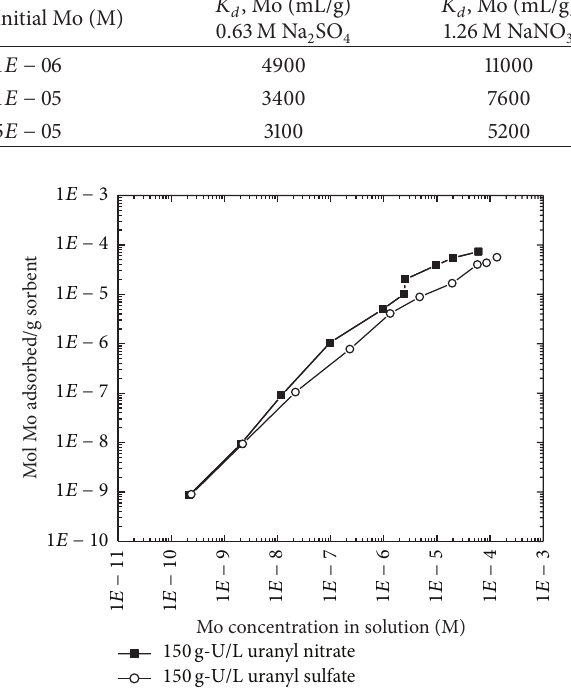
Figure 1: Amount of Mo adsorbed per gram of sorbent versus the amountinsolutioninthepresenceofsolutionscontaining150 g-U/L uranyl nitrate and 150g-U/L uranyl